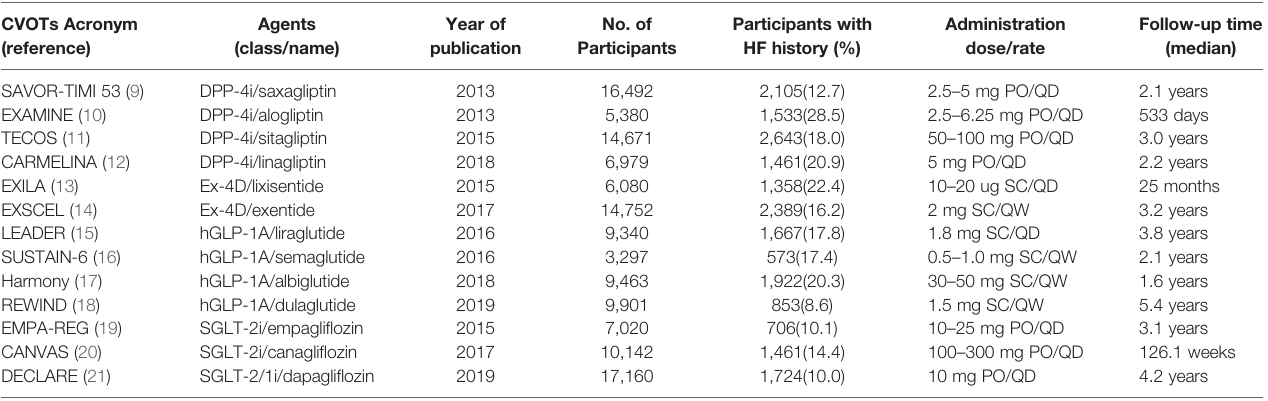
TABLE 1 | Characteristics of included cardiovascular outcome trials. CVOTs Acronym